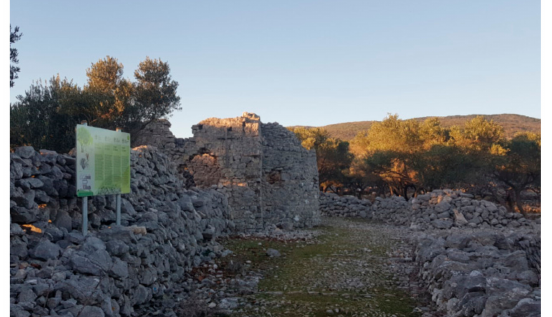
Figure 14. As the area has become a touristic site, recent landscape changes also included the addition of educational signs (Tanja Kremeni´c,